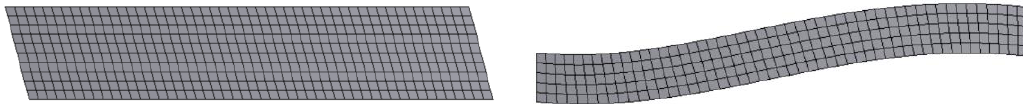
Figure 13. Total deformation of bondline-embedded d35 PZT actuators with thicknesses of 1 mm ( left ) and 0.5 mm ( right ) excited with a five-peak tone burst signal at 30 kHz.